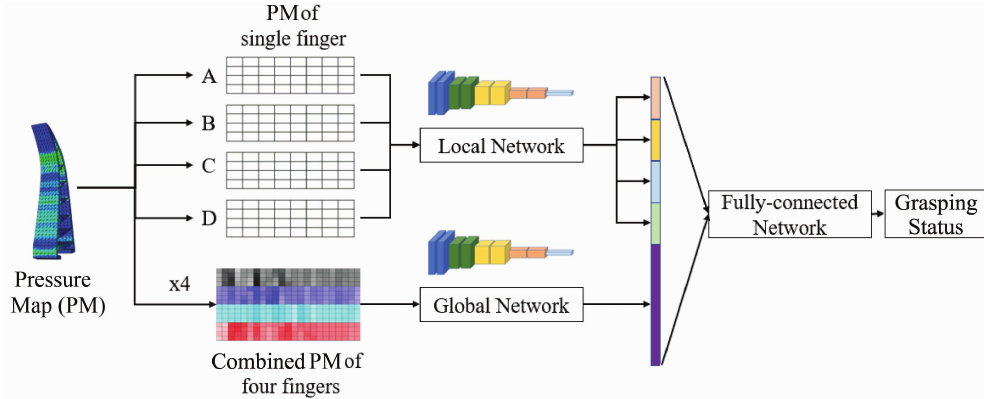
Figure 5. Proposed Deep-touch CNN network.